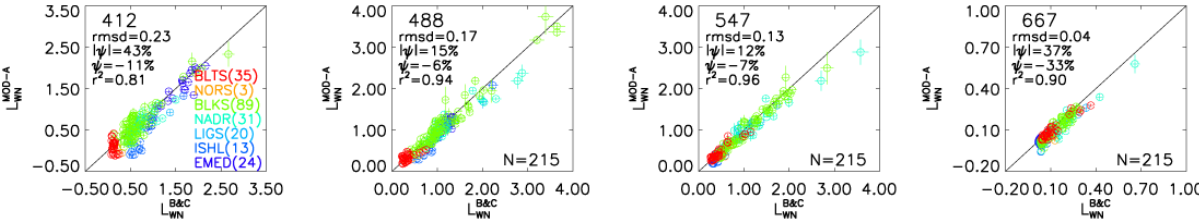
Fig. 10. Same as in Fig. 9 but for MODIS-A